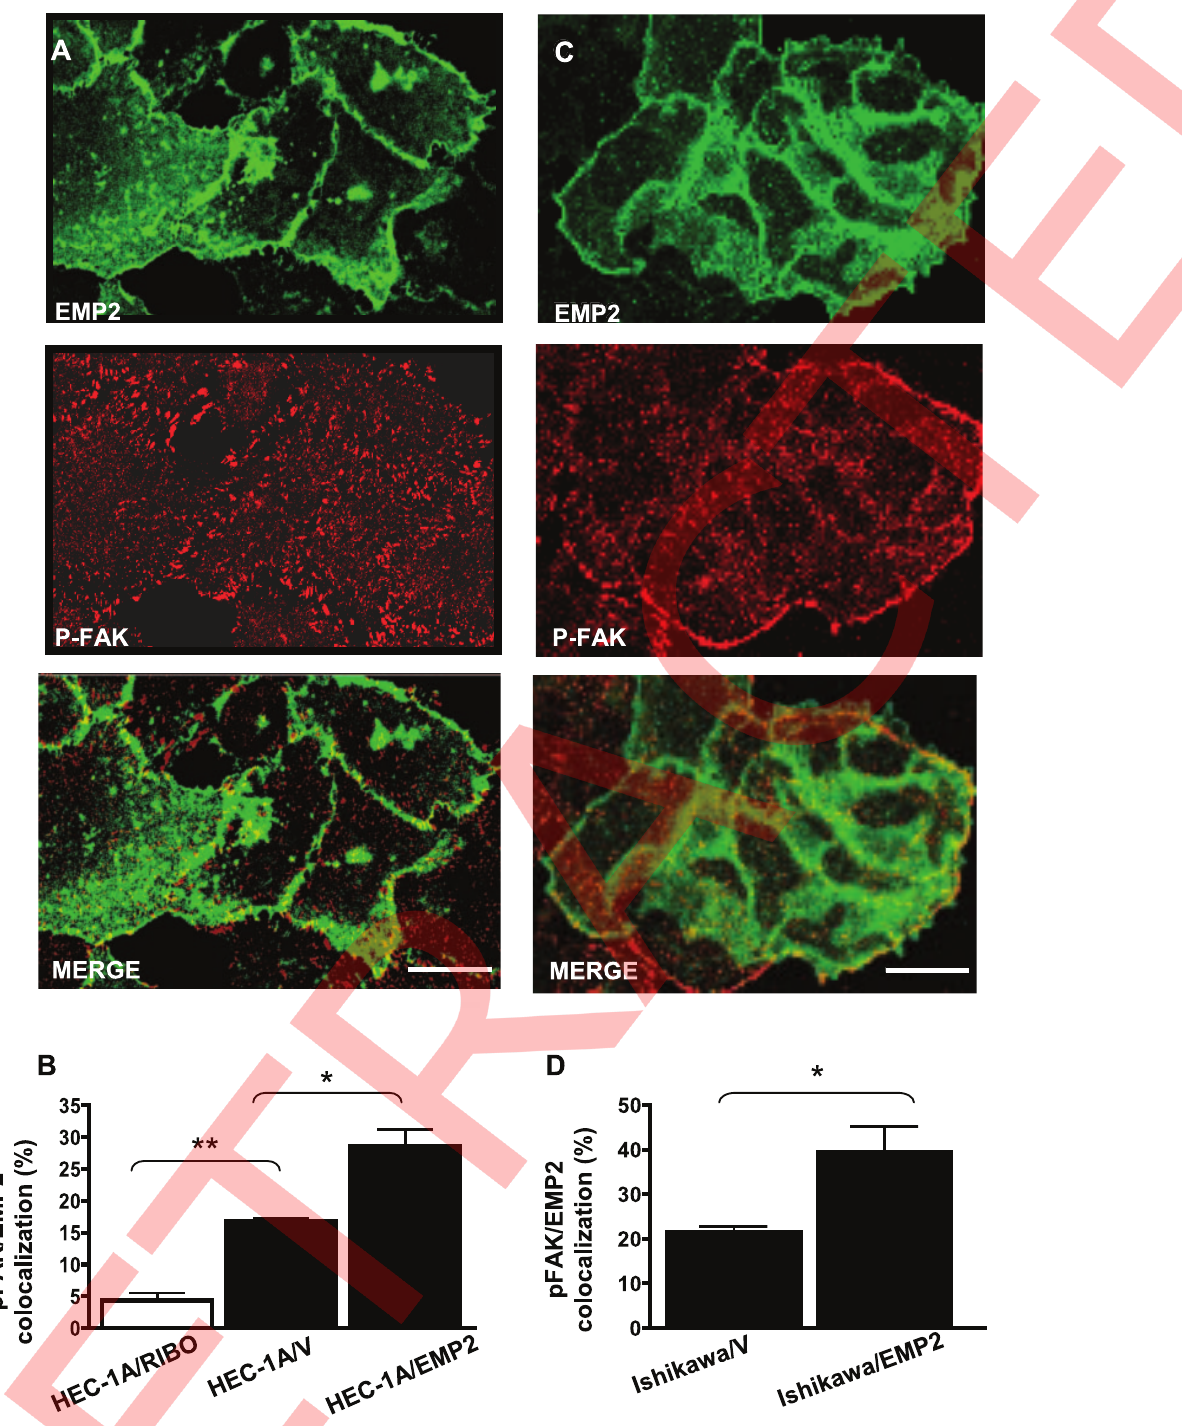
Figure 5. EMP2 and activated FAK colocalize. (A) Cellular images of HEC-1A/EMP2 cells stained for confocal microscopy using EMP2 antisera (FITC) and FAK (activated at tyrosine 397; Rhodamine). (B) Data from at least four separate samples were quantitated using Pascal software to calculate pixel intensity, and the resultant data was evaluated by Student’s unpaired t -test. Overexpression of EMP2 demonstrated a two-fold increase in colocalization with p-FAK compared to vector control cells. Less than 5% colocalization was observed in HEC-1A/RIBO cells. Student’s t test, * p=0.01; ** p=0.0001. Scale bar, 25 m M. (C) Ishikawa/EMP2 cells were stained using EMP2 antisera (FITC) and FAK (activated at tyrosine 397; Rhodamine) and analyzed by confocal microscopy. (D) Data from at least four separate samples were quantitated and analyzed as above. Student’s t test, * p=0.01. Scale bar, 25 m M.